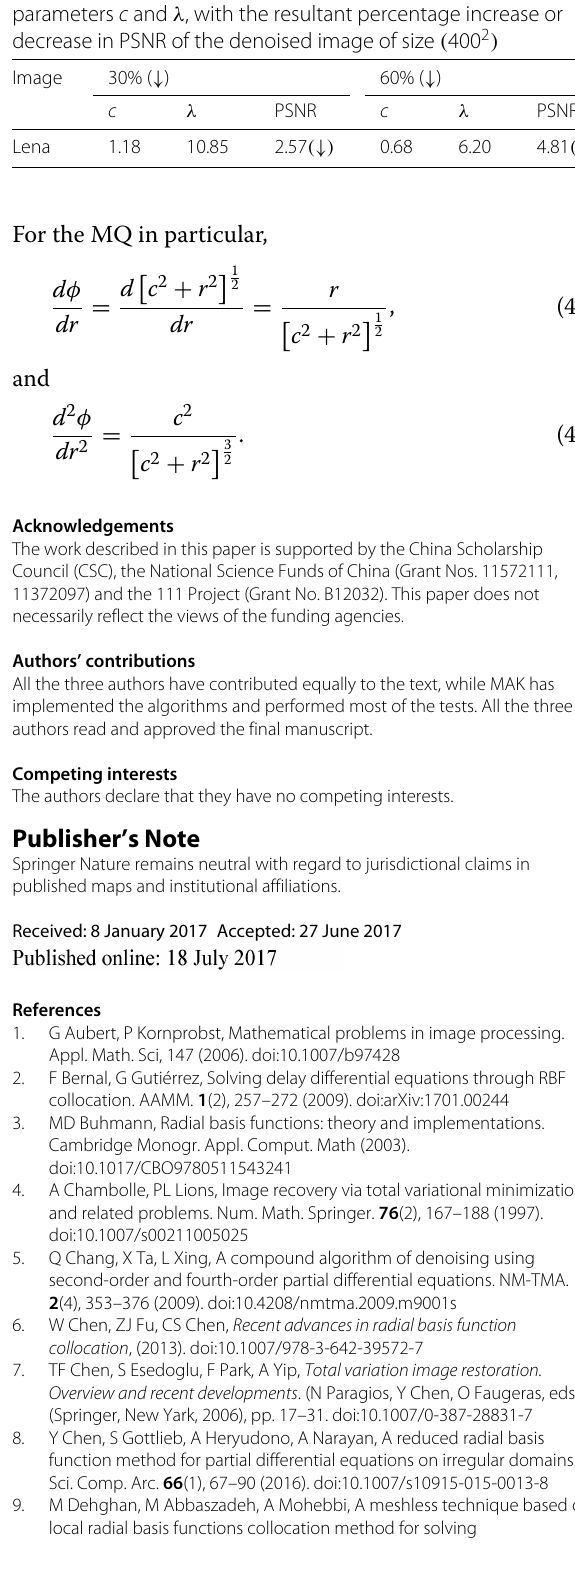
Table 6 Comparison of our method M3 with the model [18] in terms of PRNR Image